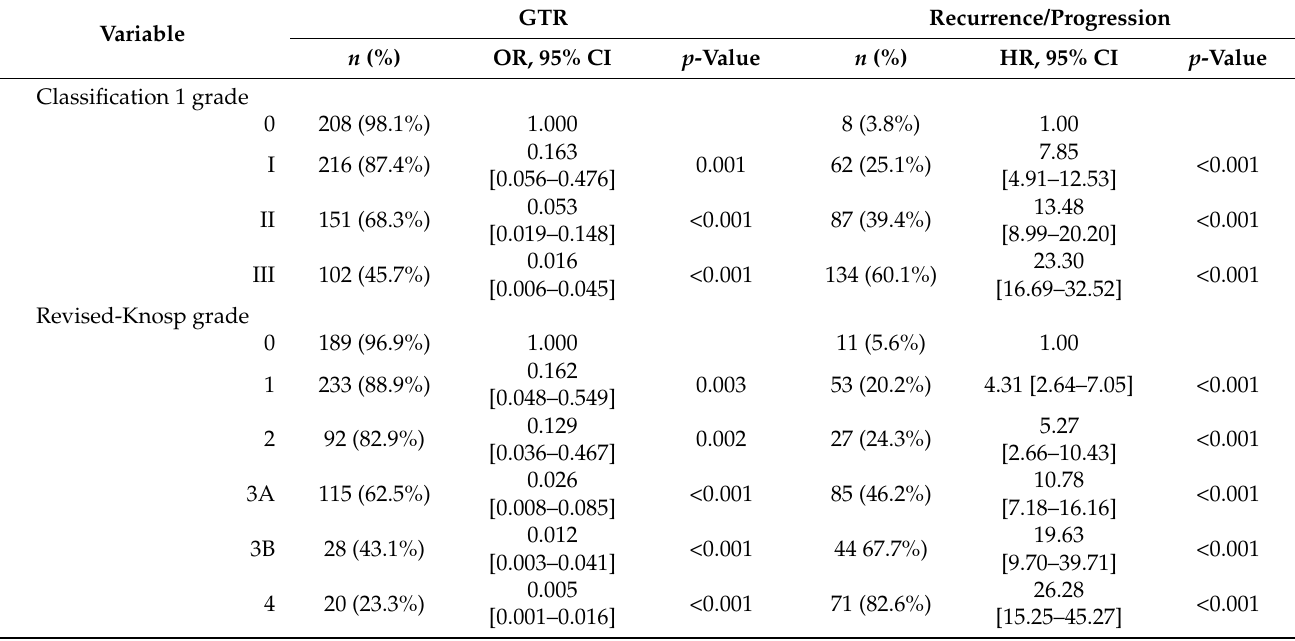
Table 3. Surgical results and recurrence/progression status of different invasiveness